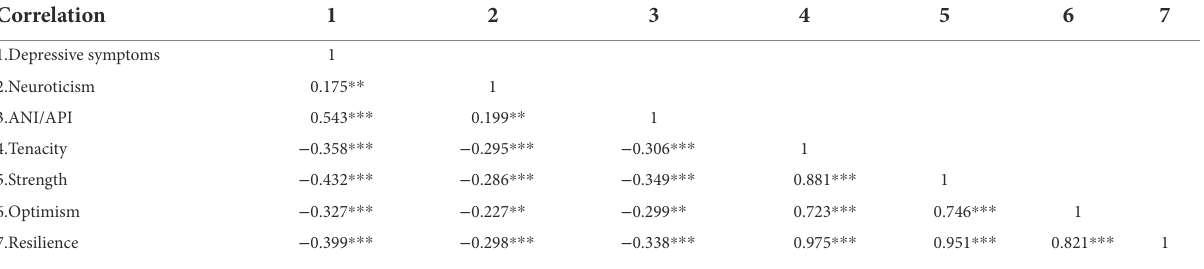
TABLE 4 Correlation analysis of depressive symptoms and resilience, neuroticism, and attentional bias in research group. Correlation